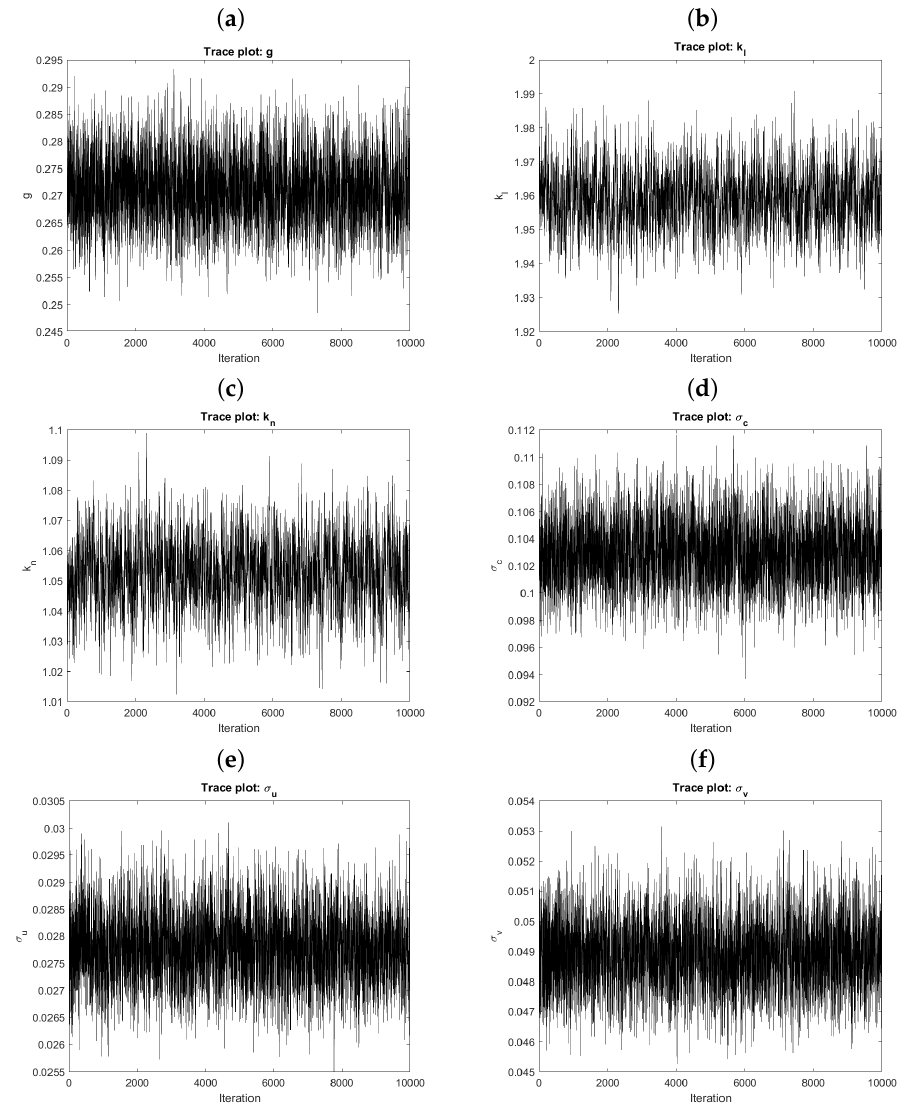
Figure A1. Exampletraceplots from the MCMC samples g (panel a ), k l (panel b ), k n (panel c ), σ (cid:101) (panel d ), σ u (panel e ), and σ v (panel f